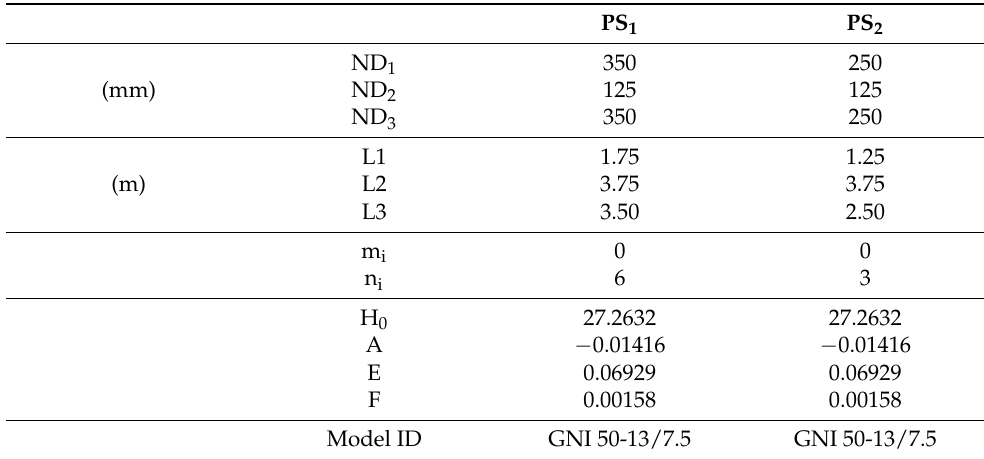
Table 3. Pump station designs for the case